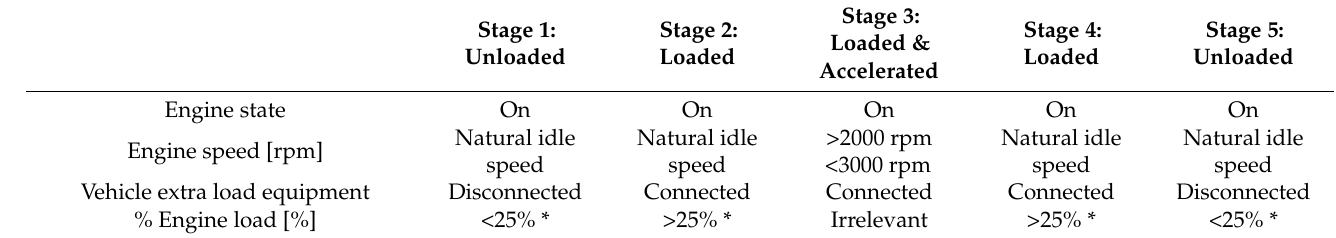
Figure 2 . Sample of stages of the Static Idling Internal Load test for NO x measurements . Table 1 . Engine running conditions for the Static Idling Internal Load Test .